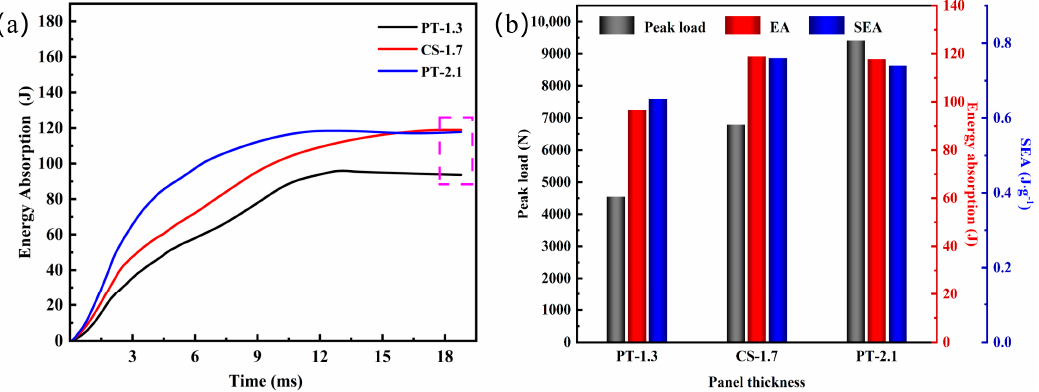
Figure 11. Evaluation of energy absorption performance at different panel thicknesses: ( a ) Energy- time curves; ( b ) A comparison of the energy absorption index of the